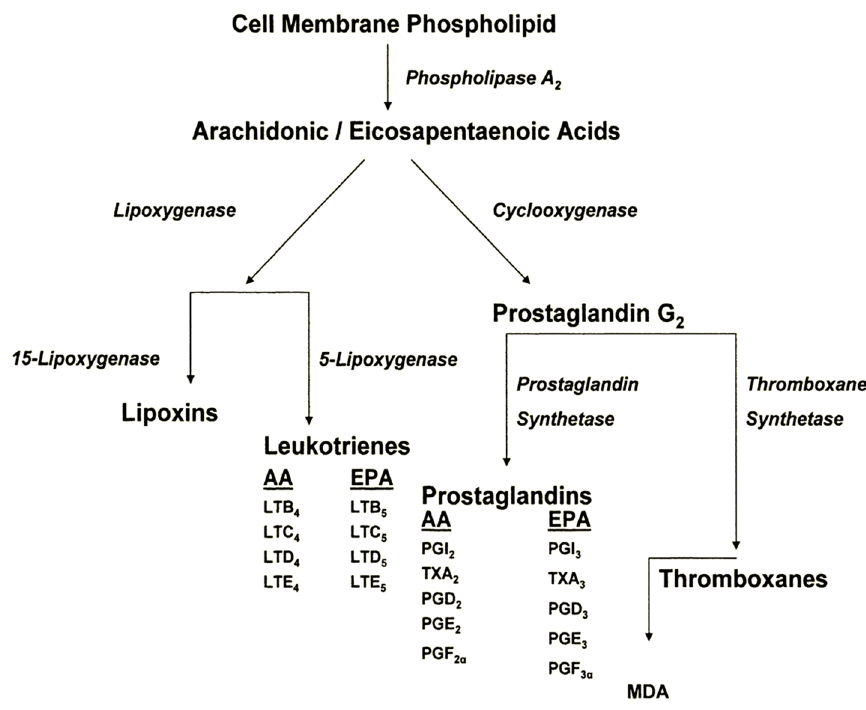
Figure 1. Differential eicosanoid metabolism from omega-6 and omega-3 FA sources. Arachidonic acid, 20:4 n -6 (AA), is metabolized via lipoxygenase and cyclooxygenase pathways. Eicosapentaenoic acid, 20:5 n -3 (EPA) acts as a competitive inhibitor to the cyclooxygenase enzyme complex with AA and produces different leukotriene and prostaglandin oxidation products. Malondialdehyde (MDA) is a product of prostaglandin and thromboxane metabolism and is commonly used as a measure of lipid peroxidation.